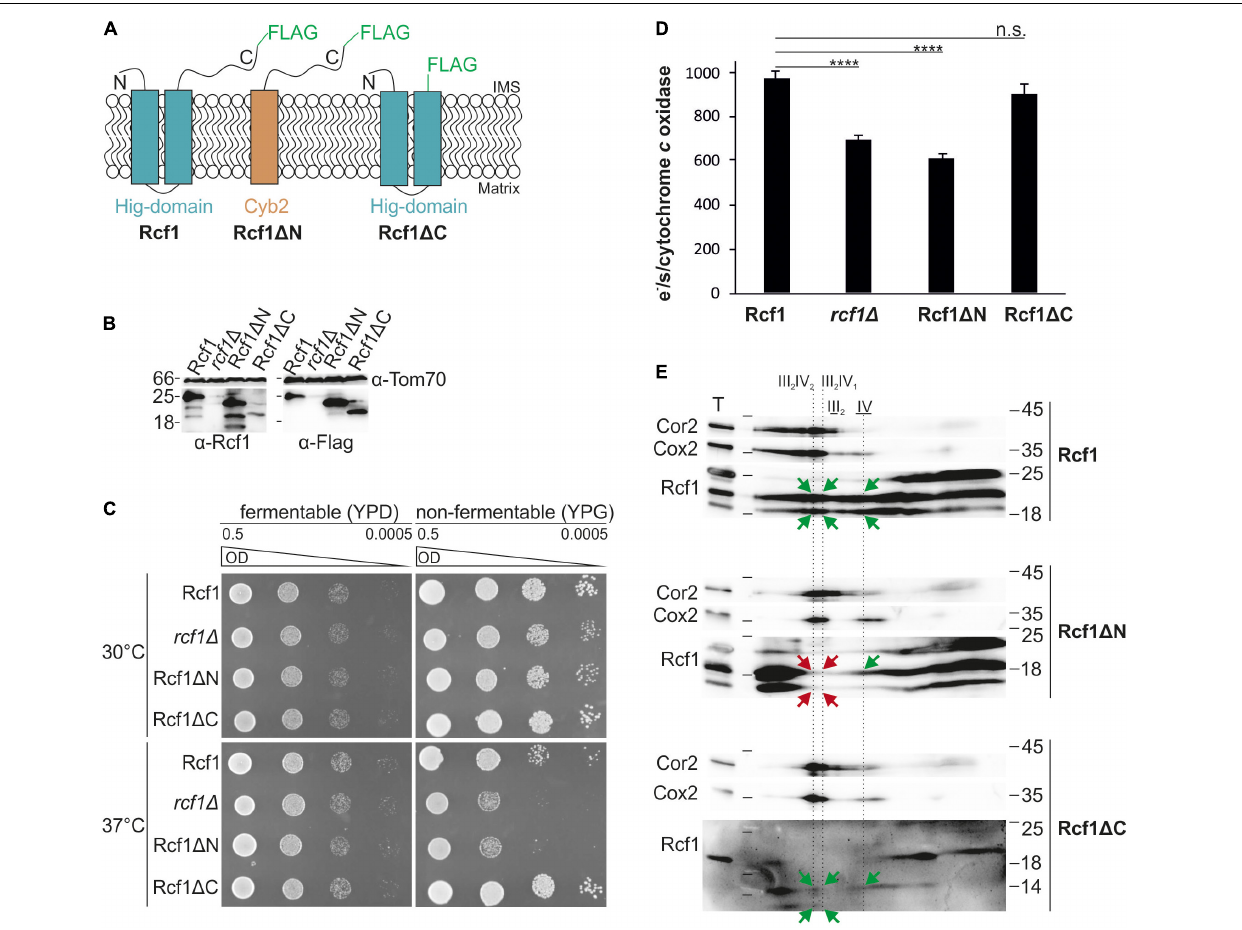
FIGURE 5 | The conserved Hig-domain of Rcf1 fulfills Rcf1 function. (A) Schematic view of truncation constructs tagged with a FLAG-tag: full-length Rcf1 (Rcf1), Rcf1 (cid:49) N (C-terminus of Rcf1 fused to Cyb2 membrane domain) and Rcf1 (cid:49) C (Hig-domain). (B) Steady state protein levels of strains expressing full-length Rcf1FLAG (Rcf1; 25 kDa), Rcf1 (cid:49) N (23 kDa), Rcf1 (cid:49) C (20 kDa) or no Rcf1 ( rcf1 (cid:49) ). Mitochondria were solubilized and analyzed using SDS-PAGE followed by Western blot and immunodecoration against Rcf1 and FLAG-peptide. Decoration against Rcf1 shows degradation products which are not visible by decorating against the FLAG-peptide indicating degradation of the FLAG-tag and not the Rcf1-protein itself. (C) A 10-fold dilution series of strains grown in YPD to logarithmic phase was spotted on YPD and YPG plates and incubated at 30 ◦ C and 37 ◦ C. Loss of the Hig-domain (Rcf1 (cid:49) N) induces a similar growth defect as loss of the entire protein while loss of the fungi specific C-terminus (Rcf1 (cid:49) C) does not affect growth. This growth phenotypes indicate that the conserved Hig-domain (present in Rcf1 (cid:49) C) is sufficient to support respiratory growth. (D) Oxygen consumption measurements to determine activity of cytochrome c oxidase activity in truncated mutants. As expected from the growth assay, loss of the Hig-domain (Rcf1 (cid:49) N) led to almost 40% decrease in activity, similar to rcf1 (cid:49) , while loss of the C-terminus (Rcf1 (cid:49) C) showed no effect on the complex activity. (E) Truncated mutants were analyzed with BN-PAGE and subsequent 2D SDS-PAGE followed by Western blot and immuno decoration against Cor2, Cox2, and Rcf1. While the C-terminus (Rcf1 (cid:49) N) can only comigrate weakly with cytochrome c oxidase (green arrow) but not with the supercomplexes (red arrows), the Hig-domain (Rcf1 (cid:49) C) retains the function to interact with cytochrome c oxidase as well as supercomplexes (green arrows). T, total; III 2 IV 2 , III 2 IV, forms of supercomplexes; III 2 , dimer of bc 1 complex; IV, cytochrome c oxidase. n.s., P > 0.05; ∗ P ≤ 0.05; ∗∗ P ≤ 0.01; ∗∗∗ P ≤ 0.001; ∗∗∗∗ P ≤